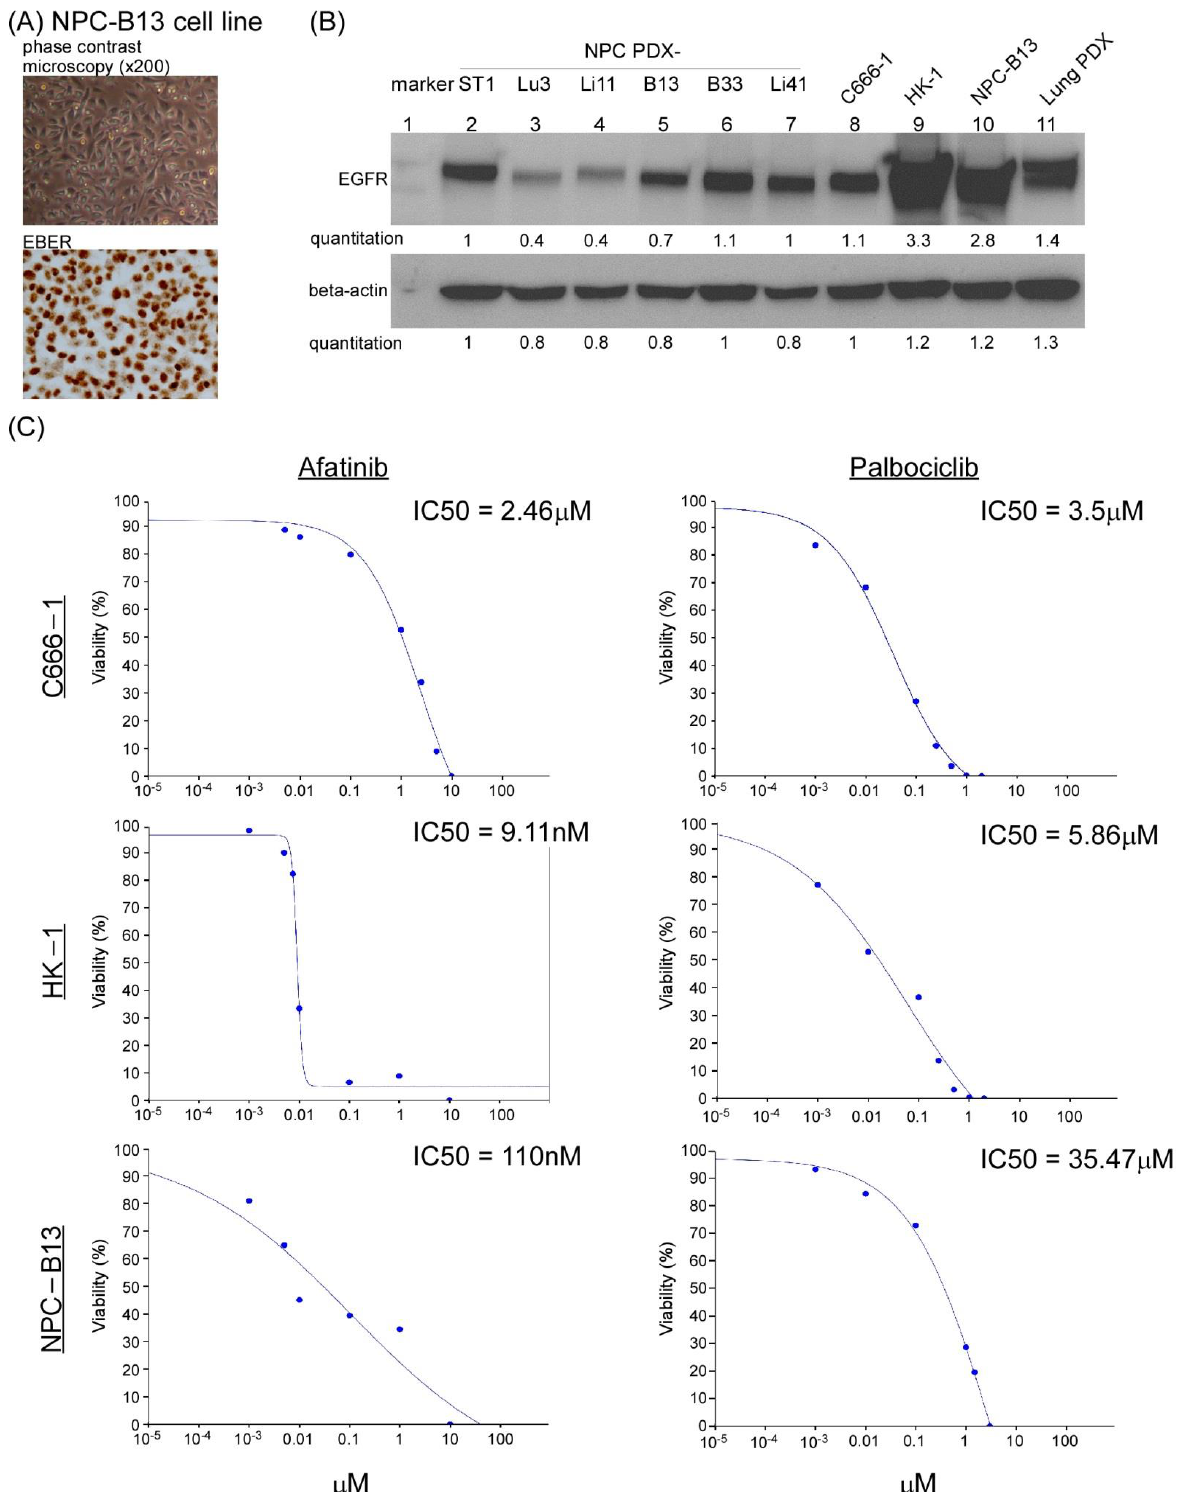
Figure 2. NPC PDX tumor-derived cell line and in vitro drug tests. ( A ) Morphology of NPC-B13 cells, a newly established EBV (+) cells derived from NPC PDX-B13 (upper panel) and its EBV encoded RNA (EBER) staining (lower panel). ( B ) Western blot analysis of EGFR expression in six NPC PDX tumors (lanes 2–7) and three NPC cells (lanes 8–10) and lung cancer PDX (lane 11, EGFR-positive control). The uncropped Western blots have been shown in Figure S1. The HPV genotyping was confirmed in Figure S2. The charcteristics of patients for the NPC PDX were listed in Table S1. ( C ) IC 50 of afatinib and palbociclib in NPC cell lines, C666-1, HK-1, and